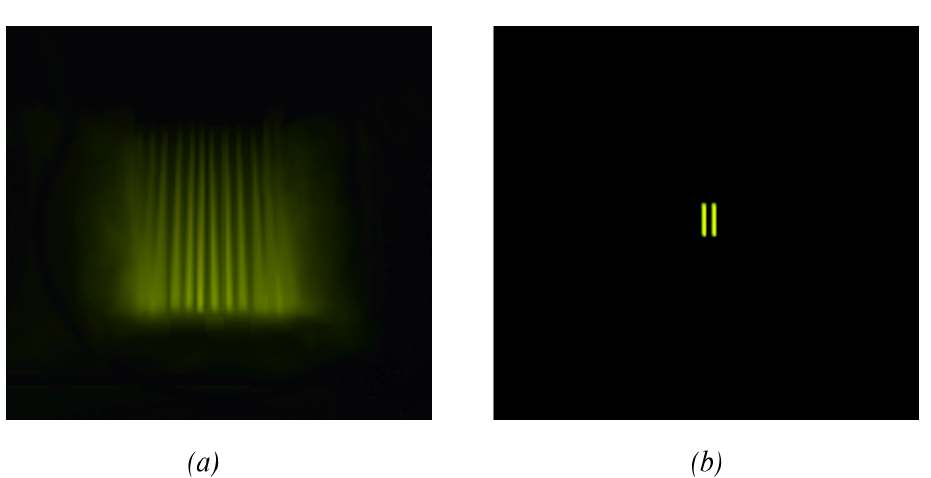
Fig 7. Sketch of observer view. (a) High light intensity. When the photon flux is high, the observer perceives fringes. (b) Low light intensity. For a low number of photons, the observer perceives the two slits. This holds even under interference